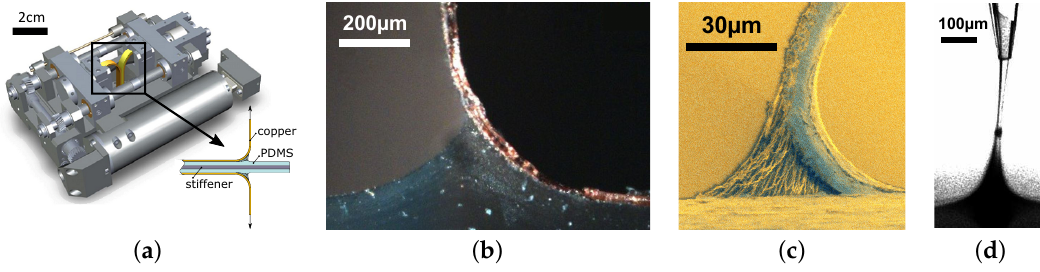
Figure 1. Illustration of the multi-scale character of fibrillating metal-elastomer interfaces: ( a ) the test specimen at macro-scale; ( b ) the PDMS (Poly(dimethylsiloxane)) lift-off geometry (FPZ) at meso-scale; ( c ) the fibrils at meso-scale; ( d ) a fibril at